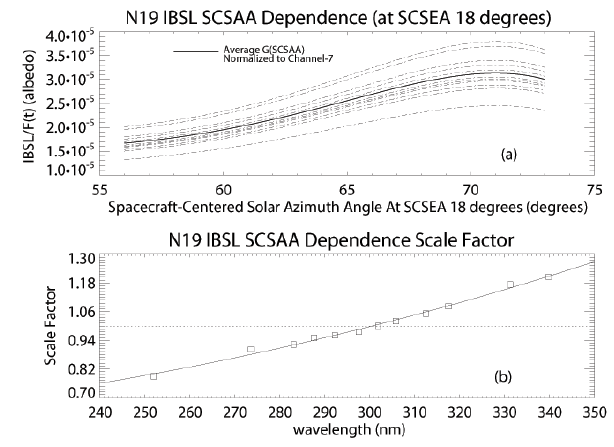
Fig. 10. (a) dIBSL/dSCSEA/F(t) can be fitted with a polynomial of SCSAA, S (SCSAA). (b) Daily values of the slope dIBSL/dSCSEA as a function of time (dots) can be approximated with F(t) × S (SCSAA( t )) (solid curve).